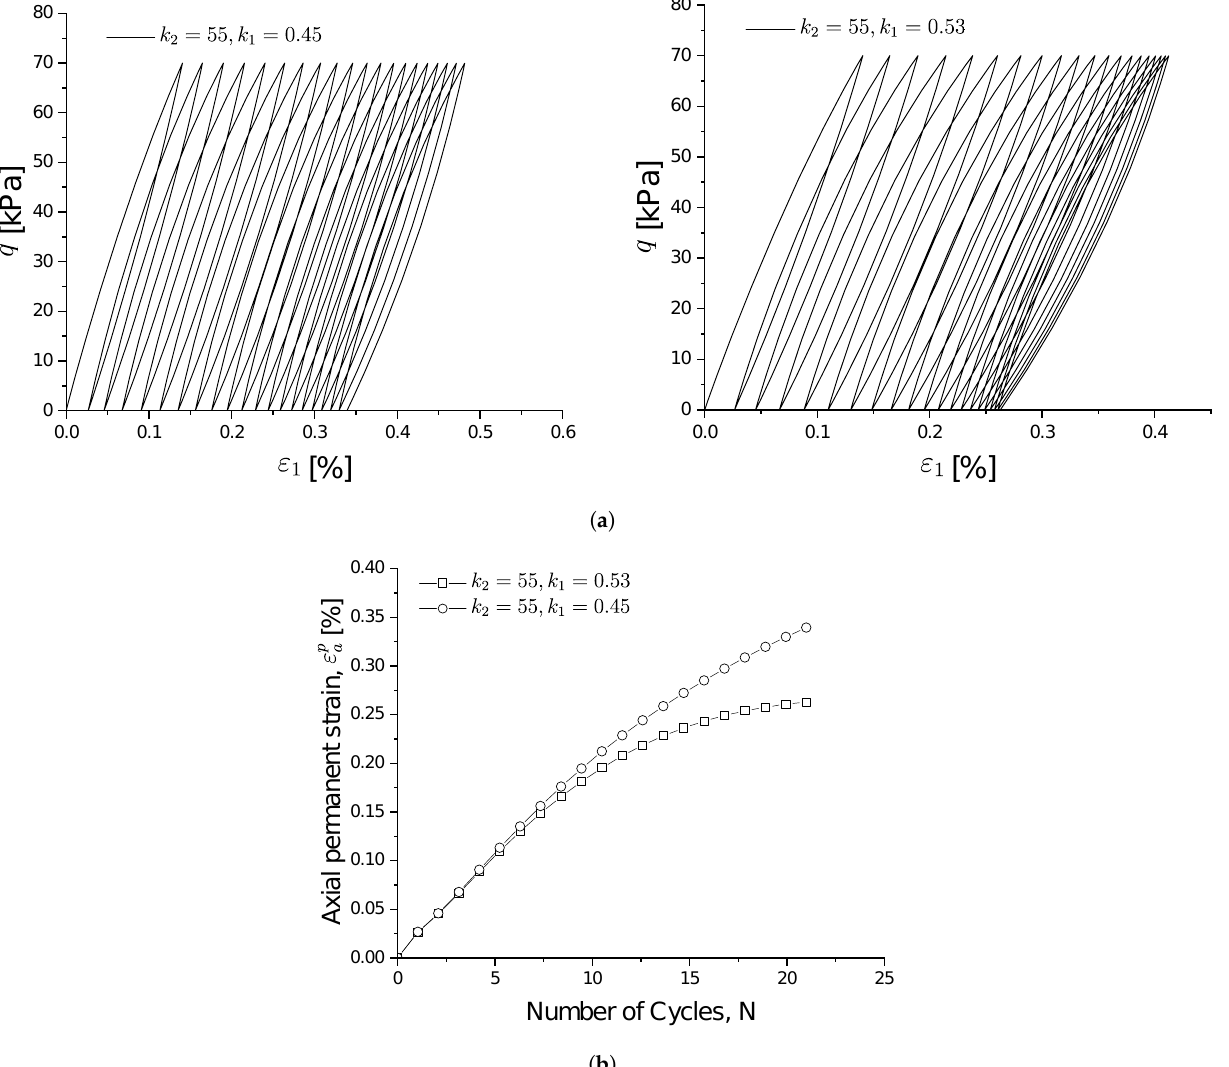
Figure 7. Influence of parameter k 1 on the cyclic stress-strain response ( a ) and on the permanent soil strain under cyclic loading ( b